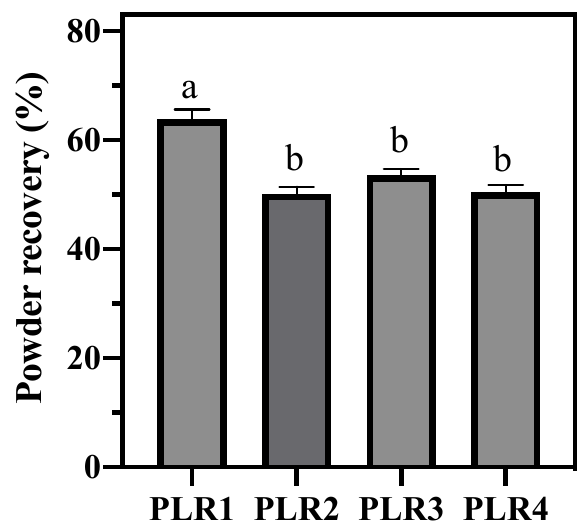
Figure 1. Powder recovery of spray-dried lipid dispersions ( n = 3). Same letter means no significant difference according to Tukey’s multiple comparison test ( p < 0.05).